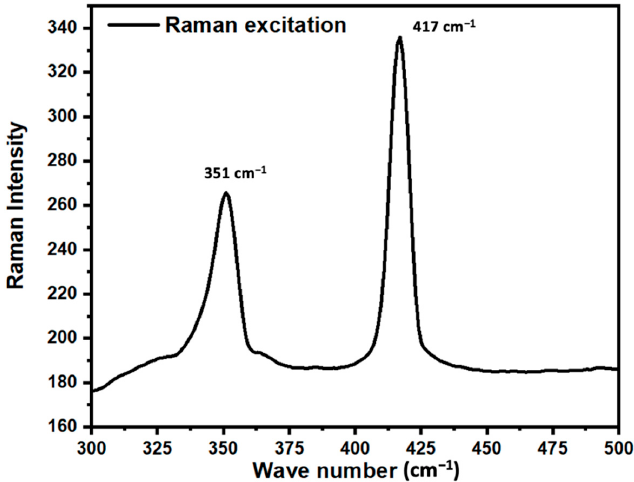
Figure 2. Raman excitation peaks of the WS 2 nanotubes.